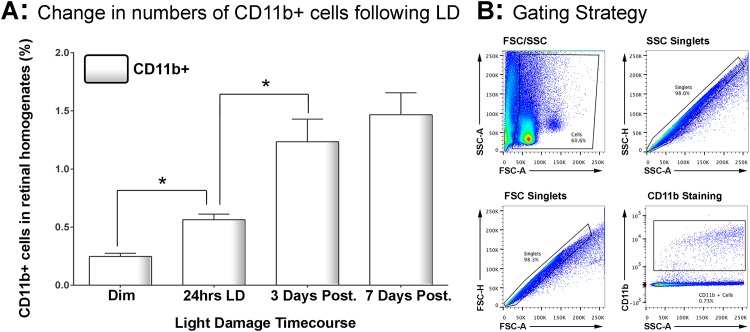
Changes the number retinal CD11b+ cells following LD.
A: Using flow cytometry, the percentage of CD11b+ cells within the retinal homogenate was found to double following 24hrs LD (P < 0.05). The proportion of CD11b+ cells continued to increase after 3 days post-exposure (P < 0.05), through was stabilised by 7 days (P > 0.05). The overall trend in CD11b+ cell number across the time course was significant by ANOVA (P < 0.05); N = 5 for each timepoint. B: Representative flow cytometry plots with gating strategies are shown for a 3 days post-exposure sample stained for CD11b; gating methodology was applied equally for all samples.